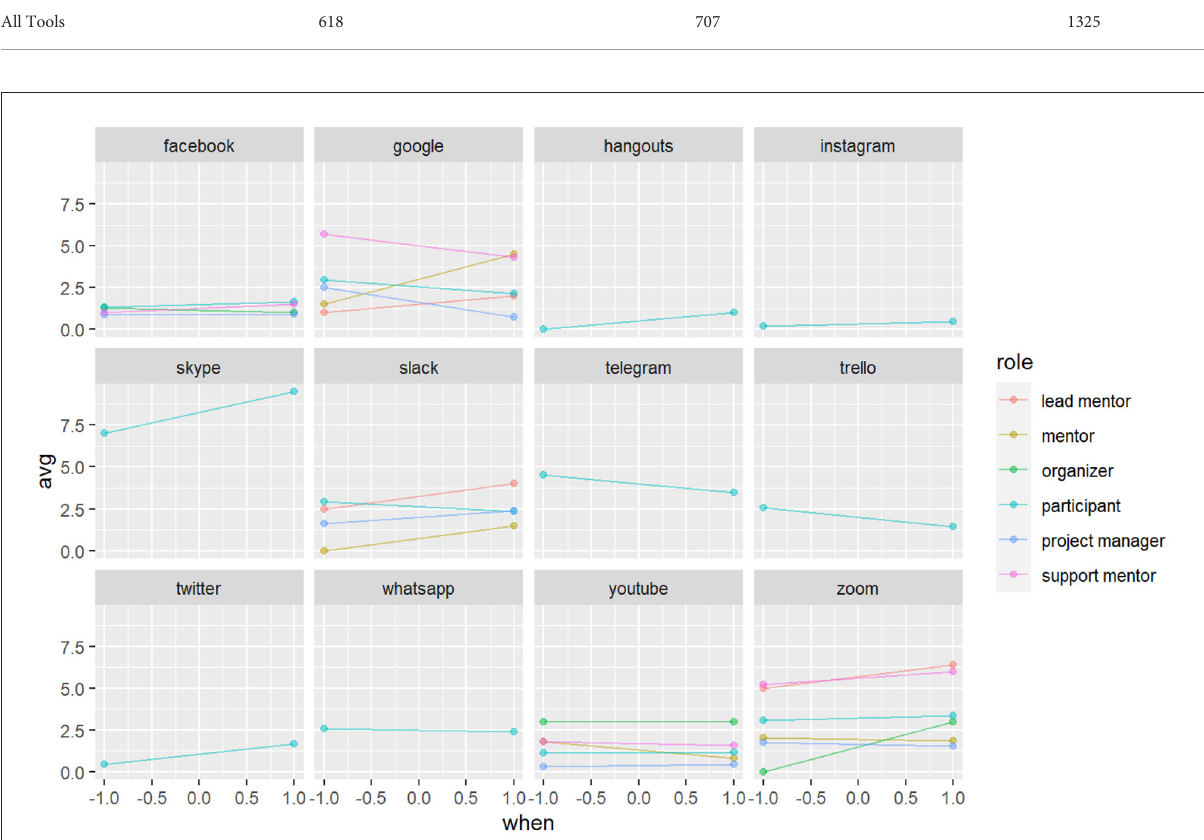
FIGURE5 Average number of messages in 10 min before (–1) and 10 min after (1) a tool mention per tool and per role of user who mentions the tool.